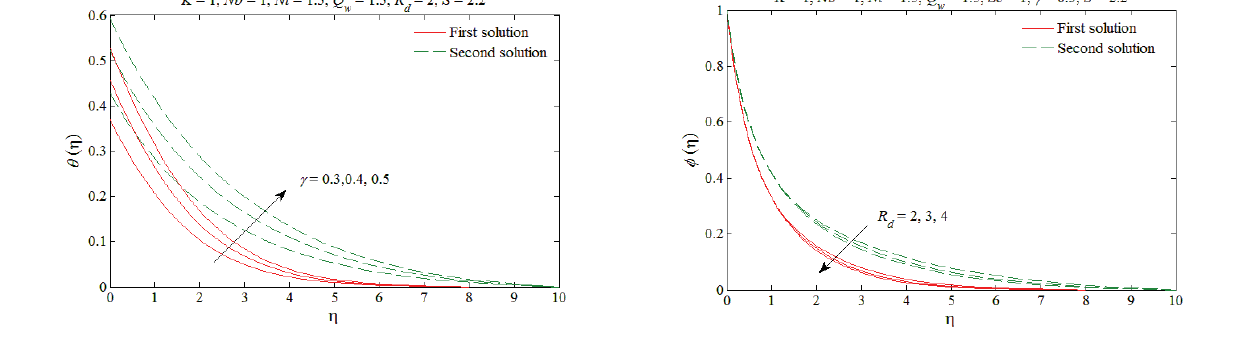
Fig. 8: The temperature profiles for different values of γ .